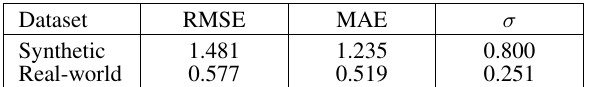
Table 2. Results for trajectory estimation after registration with the model.